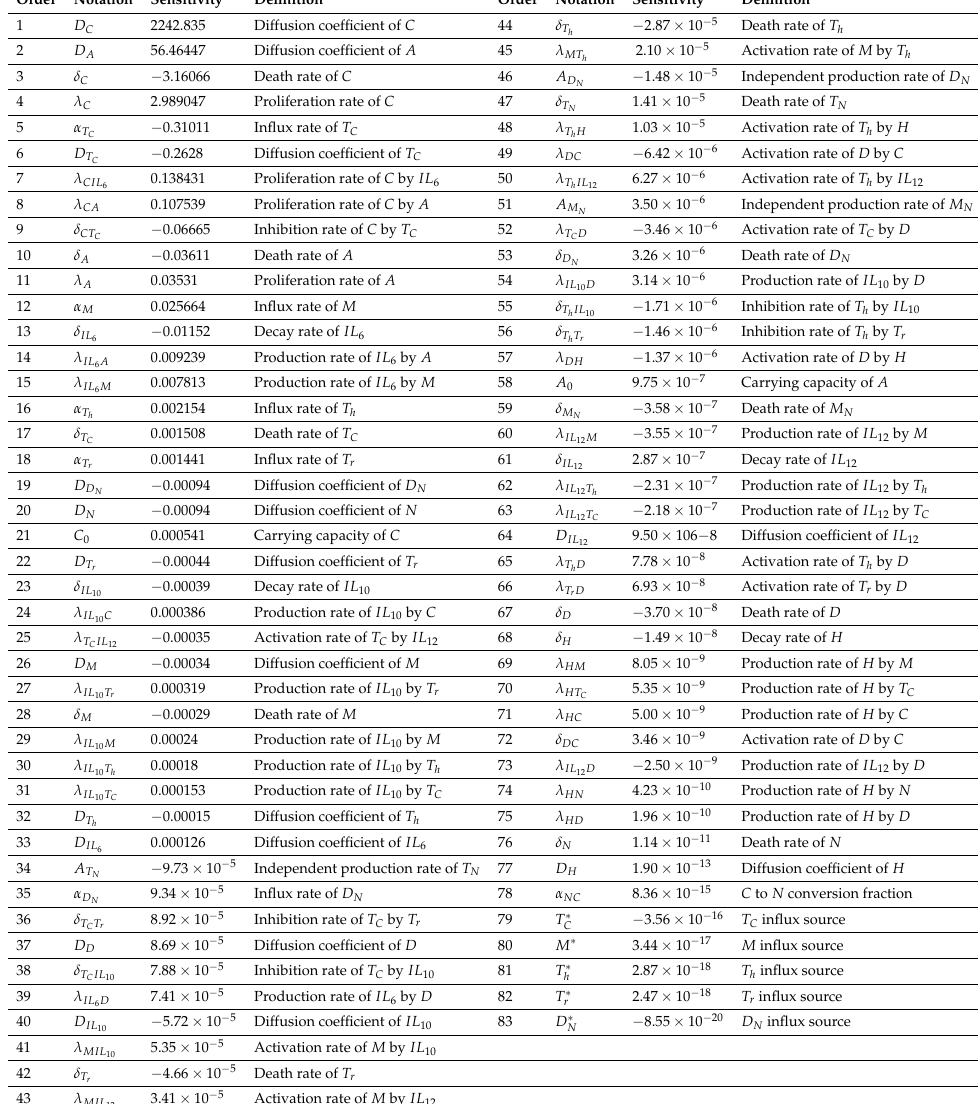
Table A1. Full sensitivity report. This table contains the sensitivity value of parameters used in the model. The rows are ordered in a decreasing fashion based on the absolute value of their sensitivity